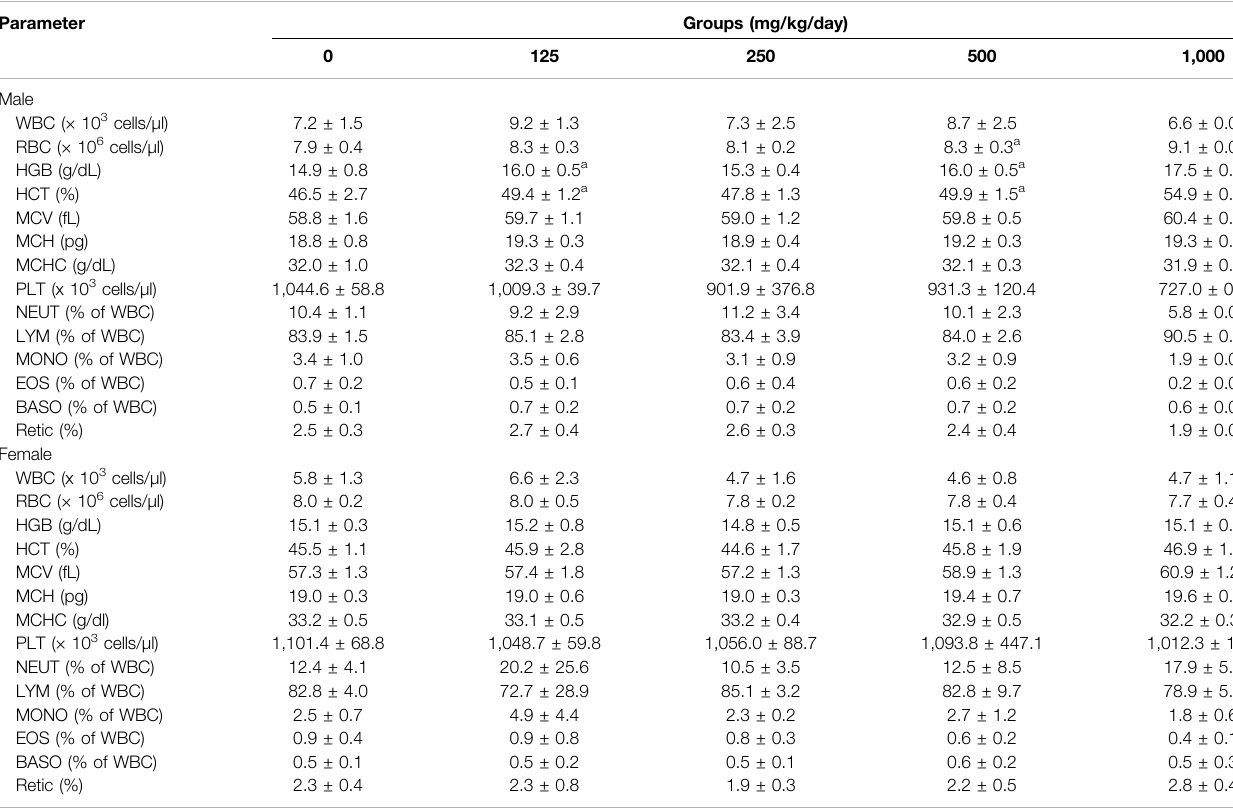
TABLE 4 | Hematological parameter of BCP in male and female rats.